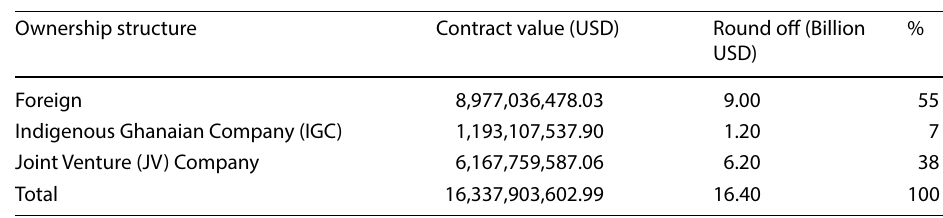
Table 1 In-country spending of petroleum operations in Ghana. Source: